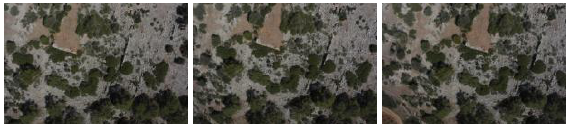
Figure 2. Images from a flight (HERICT-Project; Rhodes,